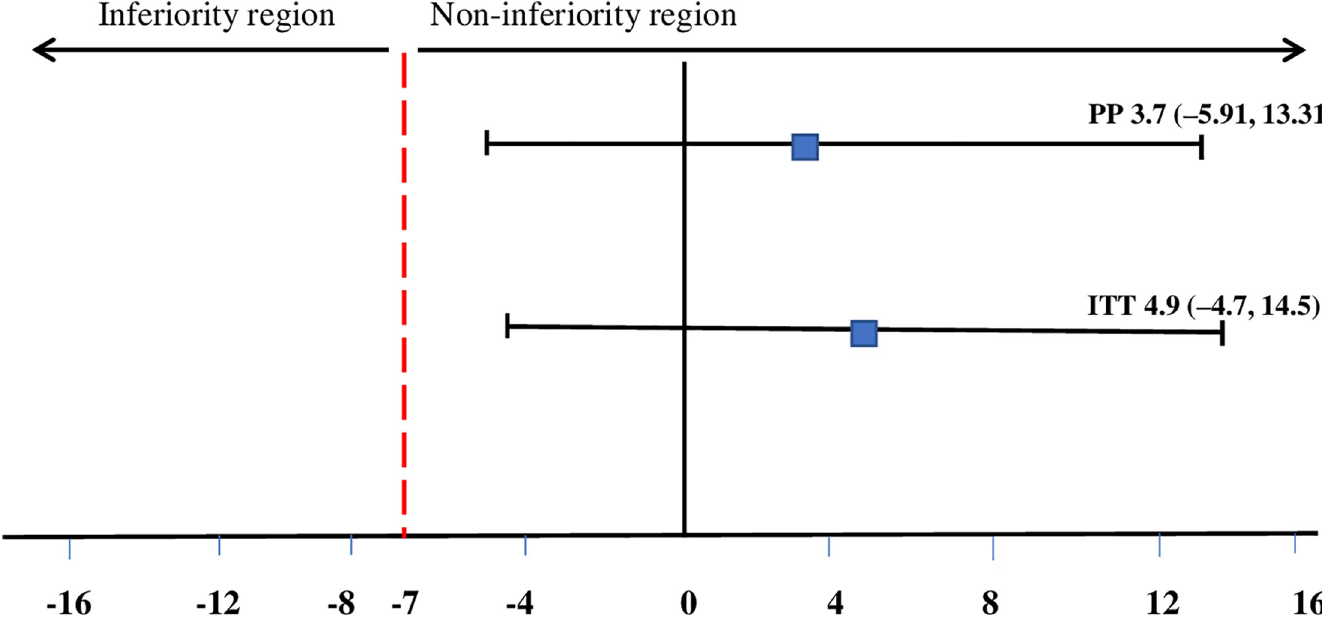
Fig 2. Difference in recovery rate between LIBS and CSB+ groups. The recovery rate in the LIBS group was non-inferior compared with the CSB+ group. Numbers are risk differences in recovery rates between groups (%). The dotted line indicates the predefined non-inferiority margin. Abbreviations: LIBS: local-ingredients-based supplement; CSB+: corn-soy blend plus; PP: per-protocol; ITT: intention to